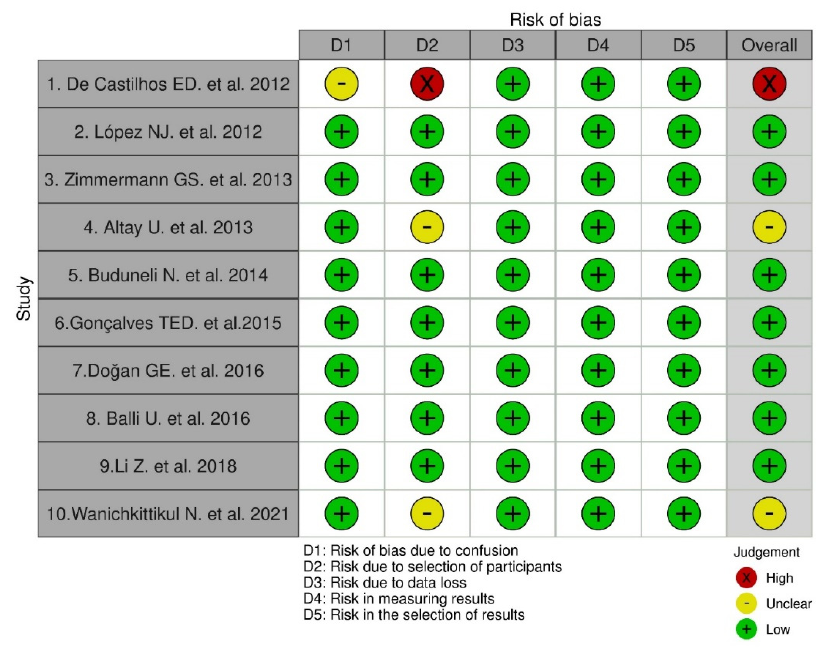
Figure 2. Risk of bias for each of the articles included.